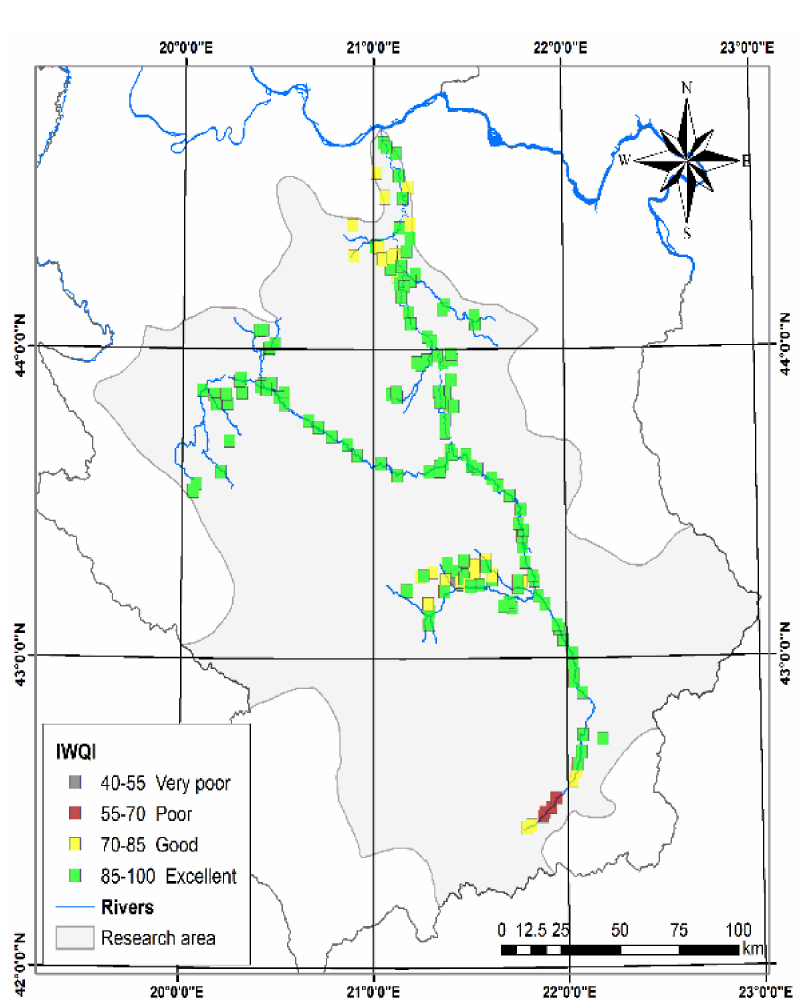
Figure 17. Spatial distribution of